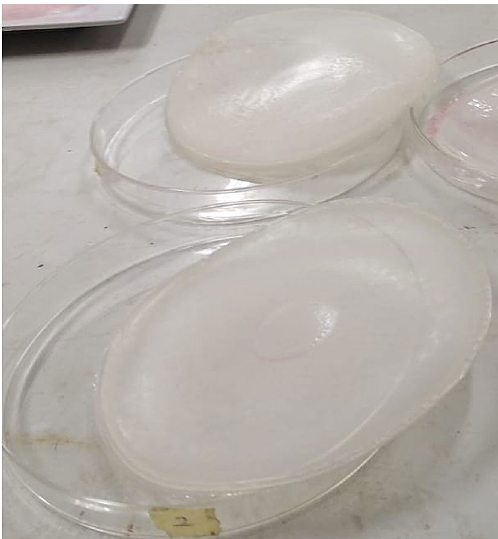
Figure 2. Nano-calcium carbonate reinforced polylactic acid